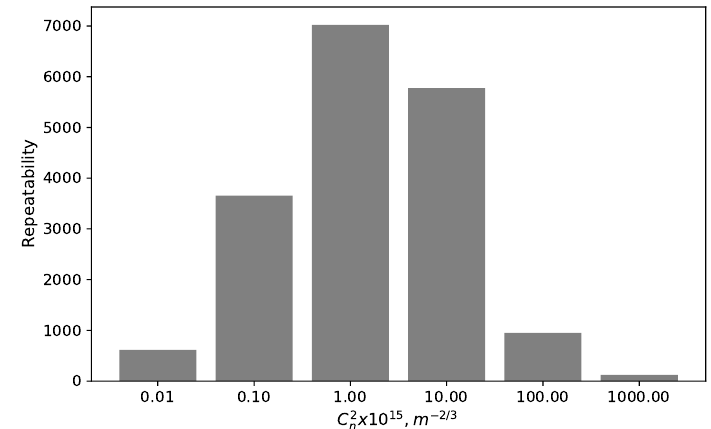
Figure 2. The repeatability of the optical turbulence at the Baykal astrophysical observatory site for the period from 1 January to 31 December